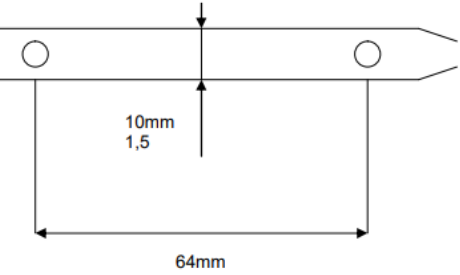
Figure A2. Flow channel of the HAAKE Minilab, provided by Thermo Fisher Scientific. The circles denote the pressure